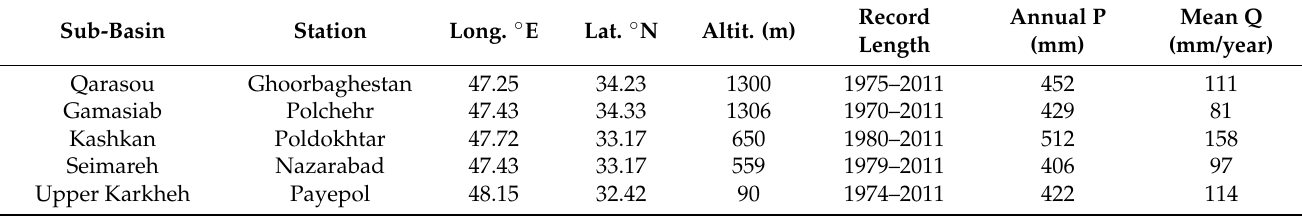
Table A3. The KRB streamflow stations, their locations, recorded length, and streamflow characteristics.